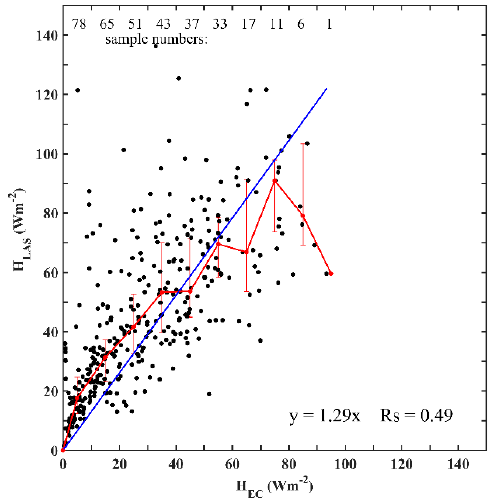
Figure 6. Variations of sensible heat fluxes (H), latent heat fluxes (LE) and net radiation (Rn) from 13 September–11 October 2015. The three days that are discussed in Section 4.3 are marked in yellow.